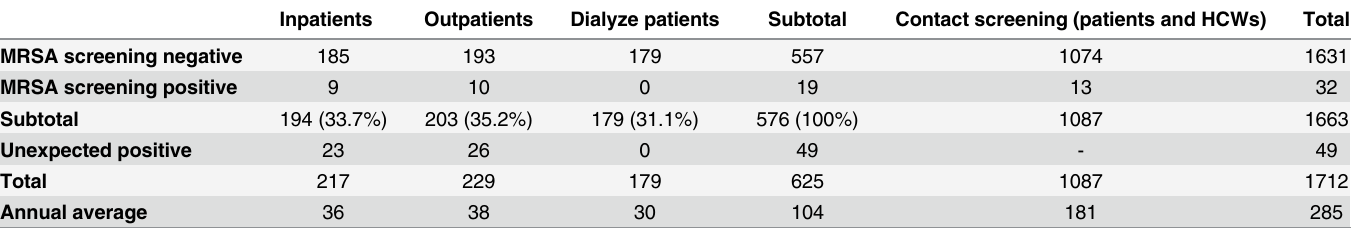
Table 2. Number of patients per category between 2008 – 2013.